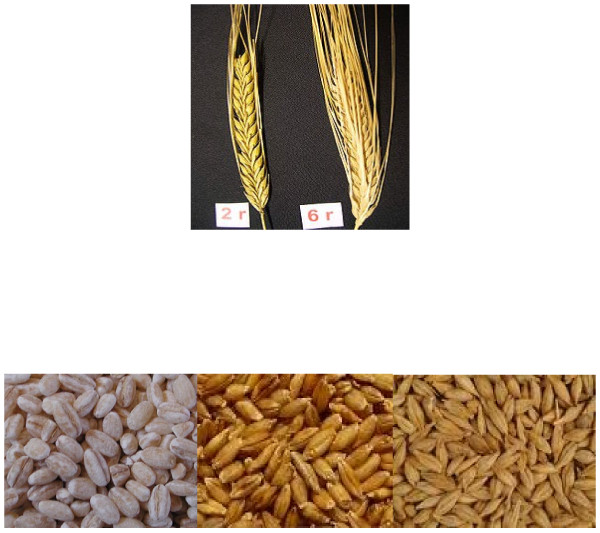
Top: Varieties of two-rowed and six-rowed barley. Bottom: Whole barley (right), naked or hull-less barley (middle) and pearled barley (left).